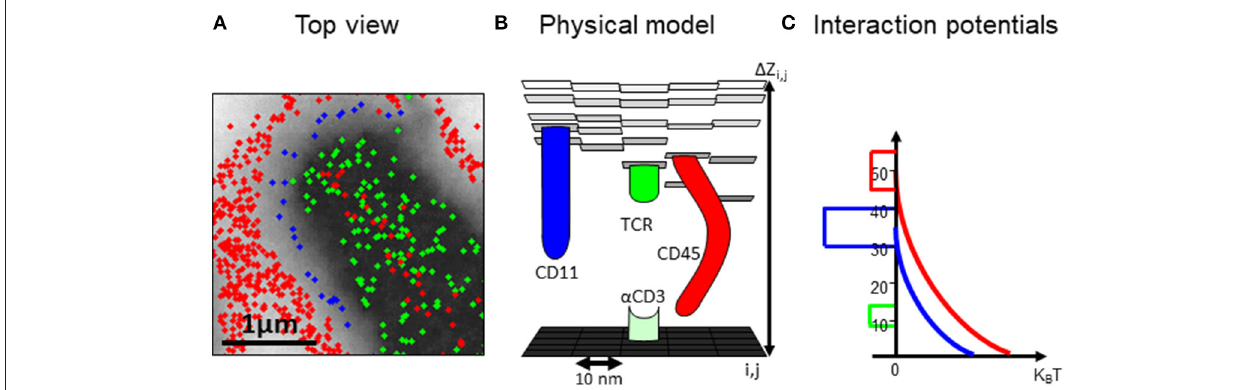
FIGURE 3 | A computational model of the intercellular interface between T cells and a coverslip. (A) A top view of a simulated membrane. The membrane is shown as a grid, where molecules (colored circles) are embedded and can diffuse and interact. Membrane height is marked by variable gray levels. (B) A 3D view of the simulated membrane. (C) The interaction potential between molecules embedded in the simulated membrane.